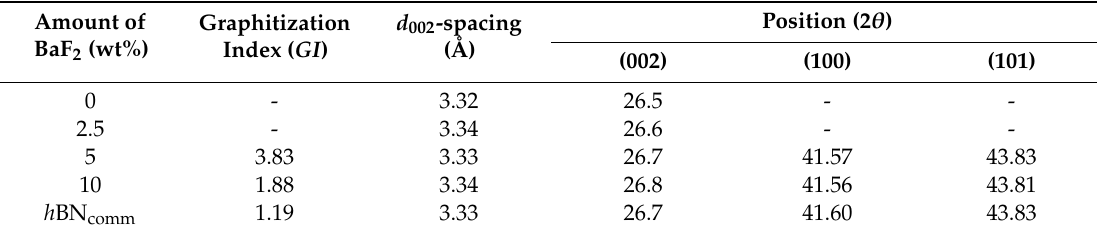
Table 1. XRD parameters of h BN nanosheets in comparison to the commercial h BN.